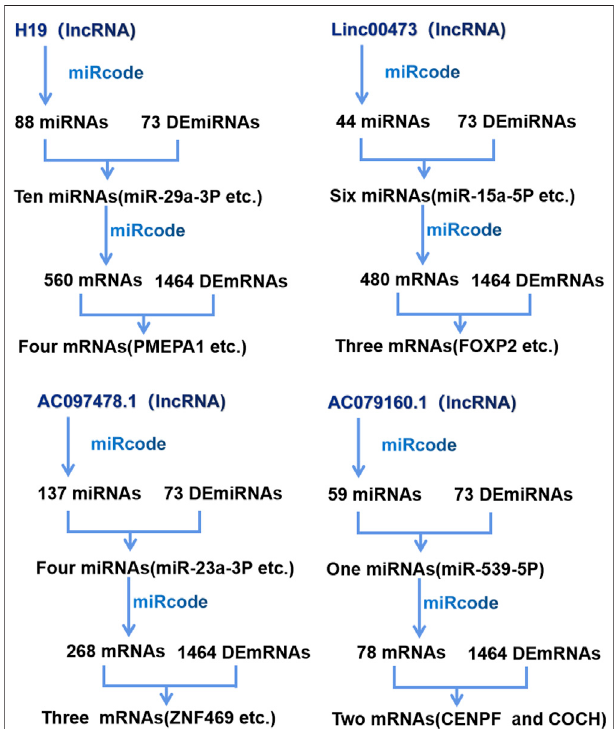
FIGURE 3 | Construction of the competitive endogenous RNA (ceRNA) network. DERNA, differentially expressed RNA; lncRNA, long noncoding RNA; miRNA, micro RNA; mRNA, messenger